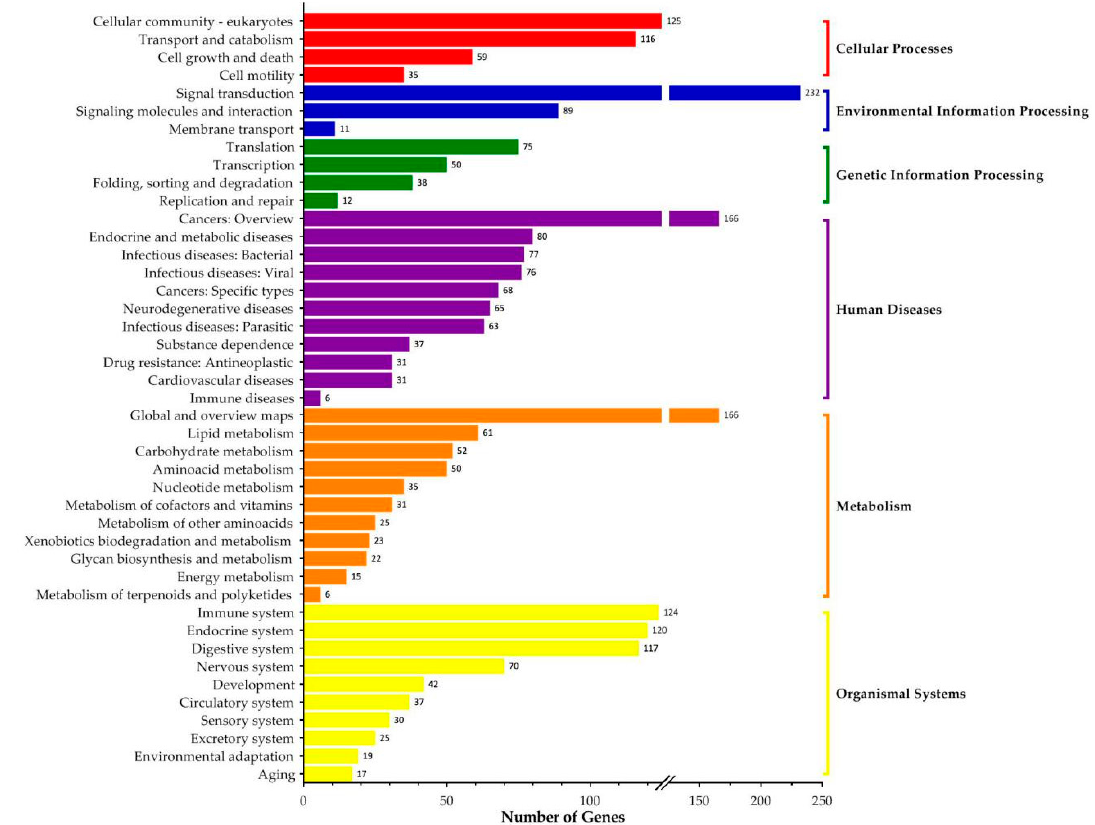
Figure 6. Kyoto Encyclopedia of Genes and Genomes (KEGG) classifications of differentially expressed genes of B. xylophilus in aseptic condition and with S. maltophilia .